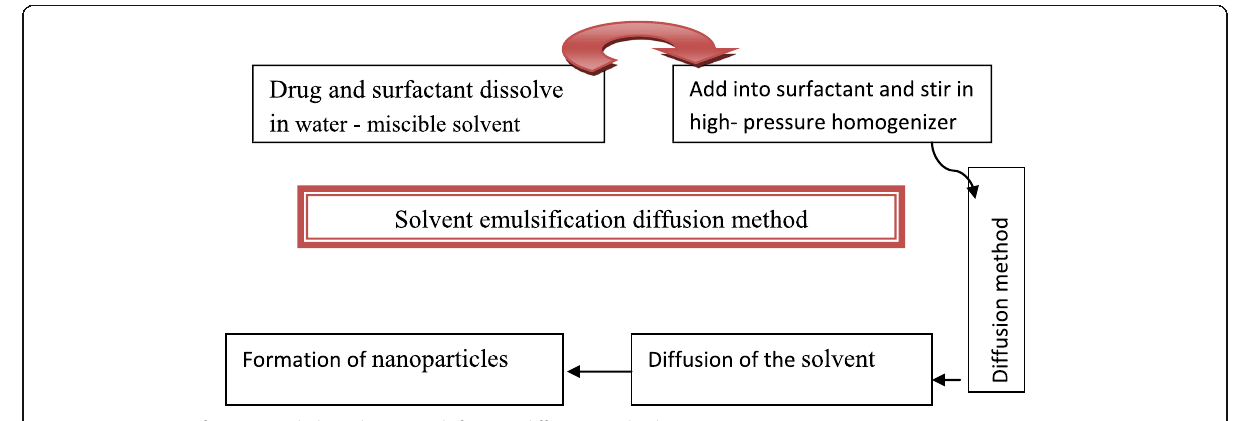
Fig. 6 Preparation of nanoparticle by solvent emulsification diffusion method